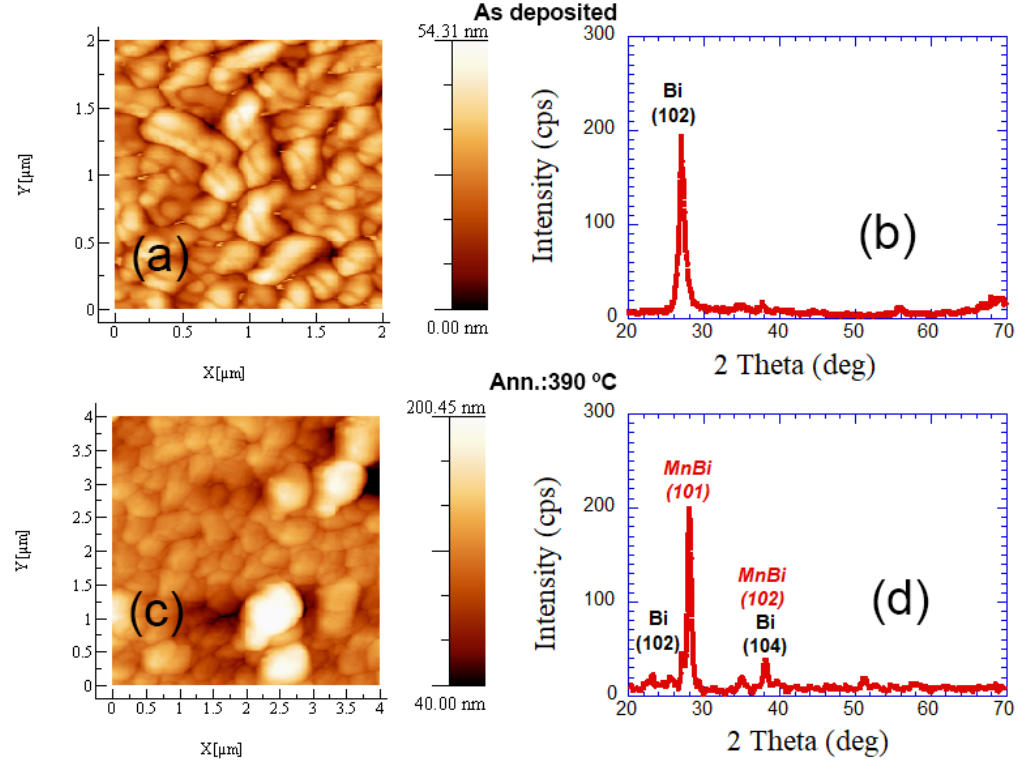
Figure 3. AFM image and X-ray diffraction pattern of the as-deposited Mn(35%)Bi(65%) sample ( a , b ) respectively. For the 390 °C annealed sample, the AFM image is plotted in ( c ), while the corresponding X-ray diffraction pattern is shown in ( d ).